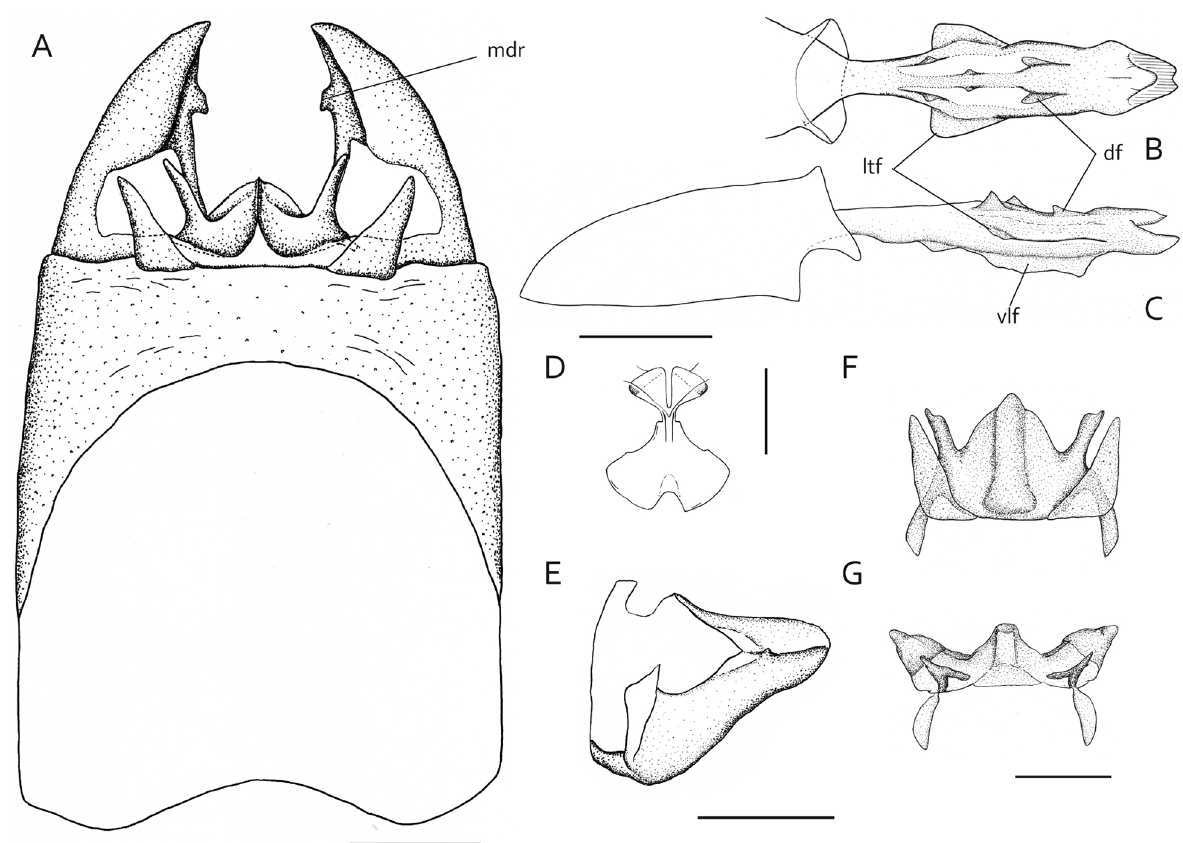
Figure 4. Male genitalia of Melinopteryx coruscans sp. n. [holotype]. A: genitalia capsule, dorsal view; B: phallus, dorsal view; C: ditto, lateral view; D: median plate; E: left valva, inner view; F: tergum X and venter X plate, dorsal view; G: ditto, oblique view; H: genital capsule, lateral view. Abbreviations: df =dorsal fin; ltf = lateral triangular fin; mdr = mid-dorsal ridge; vlf = ventral longitudinal fin. Scale bars: 0.2